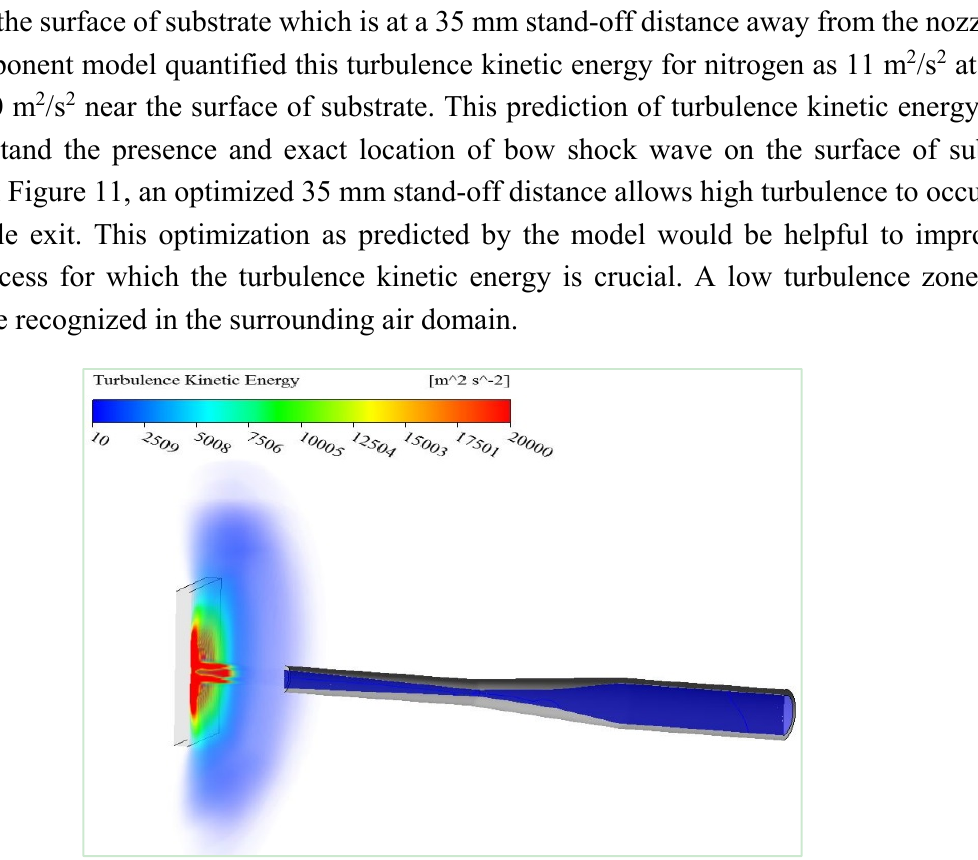
Figure 11. Simulation of gas turbulent kinetic energy for cold spray supersonic jet at 800 °C and 3 MPa estimated holistically from nozzle stagnation zone to the substrate surface, predicted by 3D multicomponent